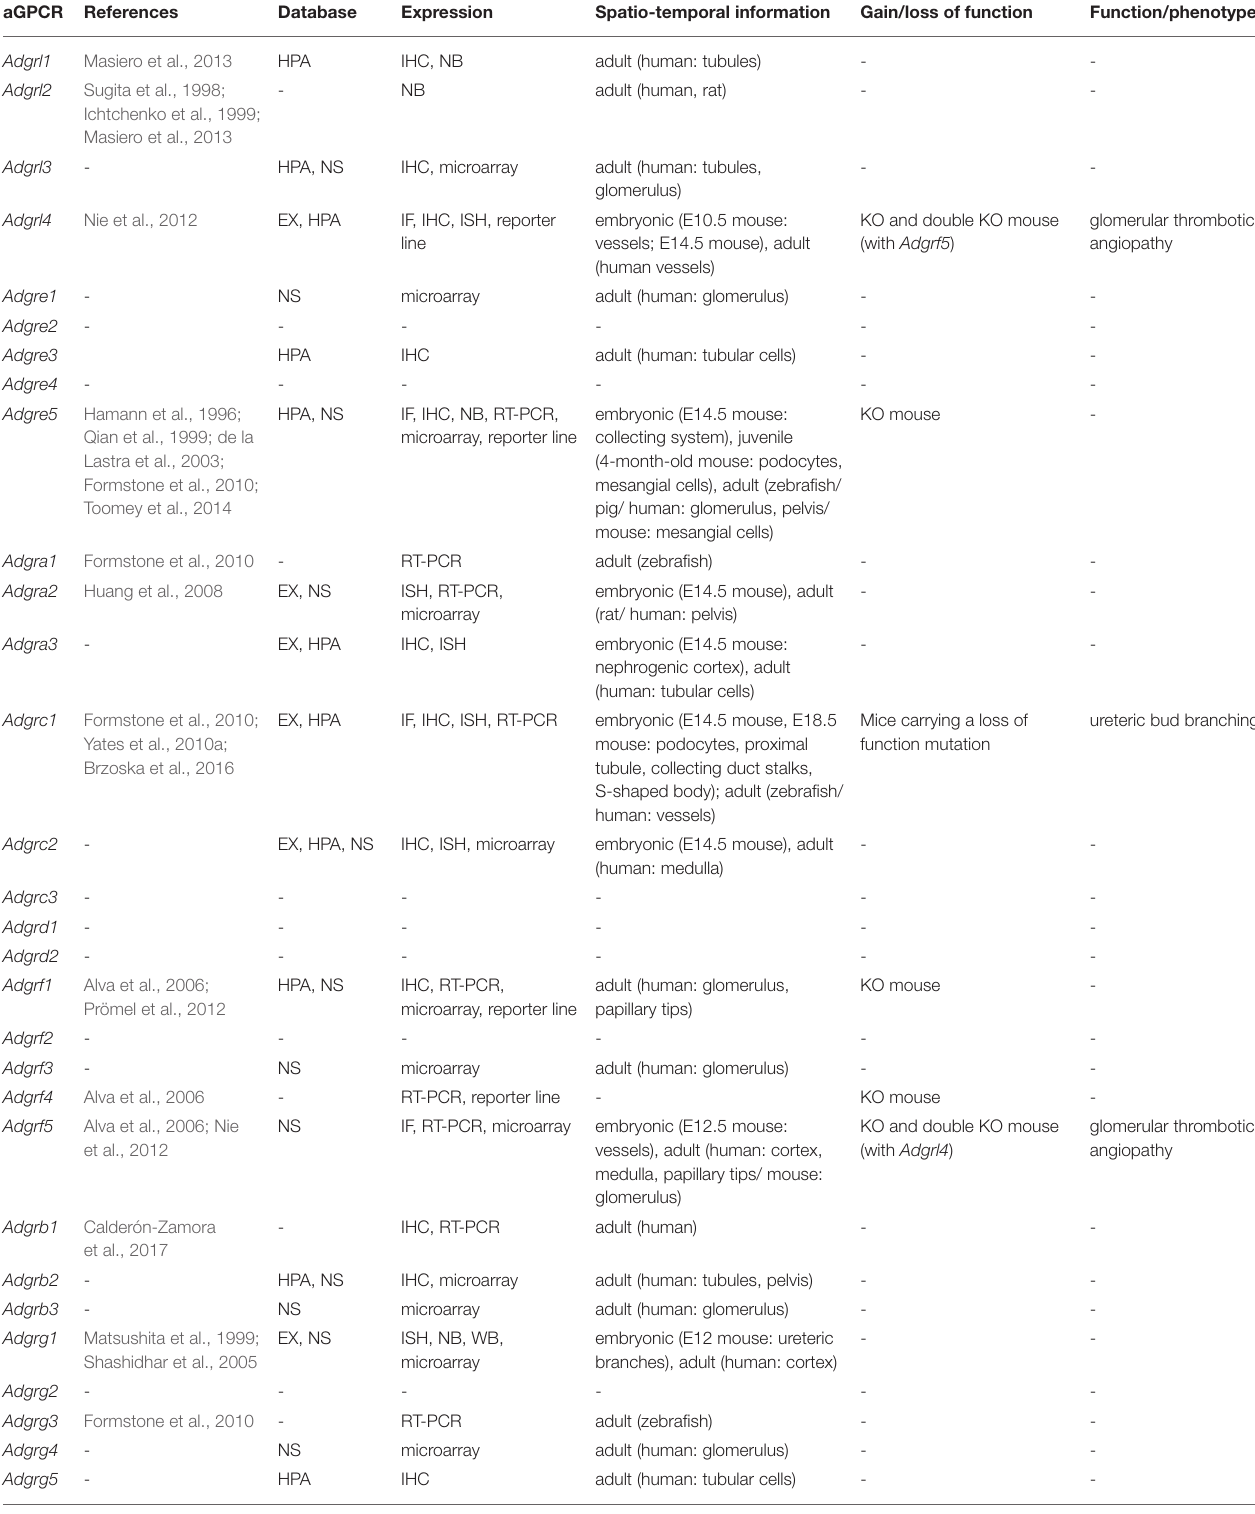
TABLE 1 | Adhesion GPCRs associated to kidney